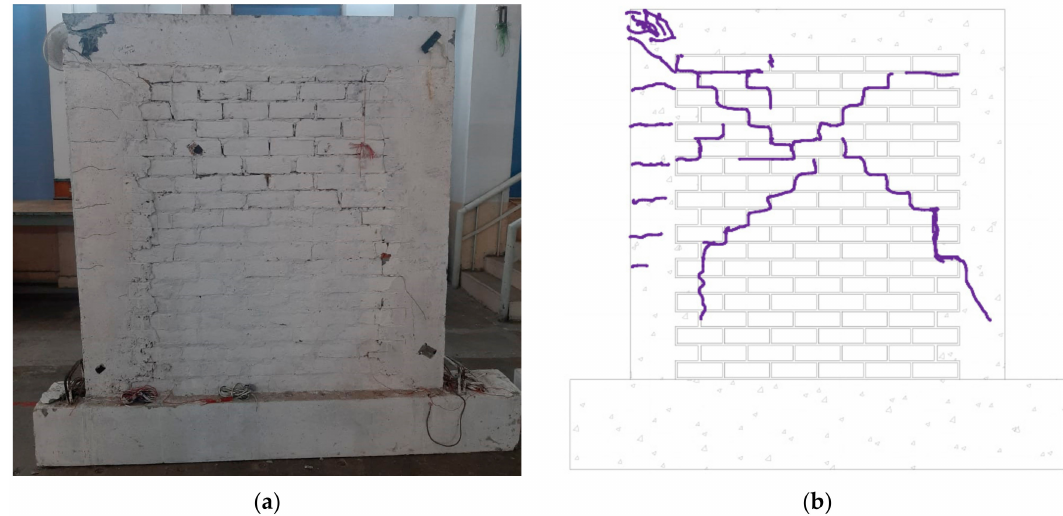
Figure 14. Crack pattern of OPC-CM ( a ) failure pattern of actual sample, ( b ) crack pattern